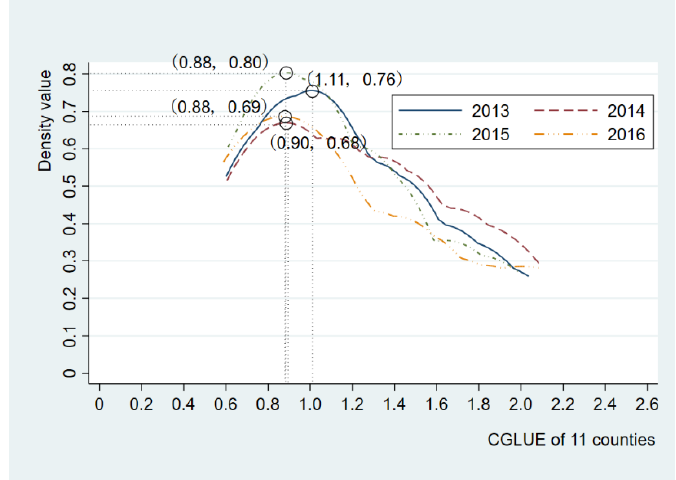
Figure 8. Efficiency kernel density curve from 2010 to 2012.